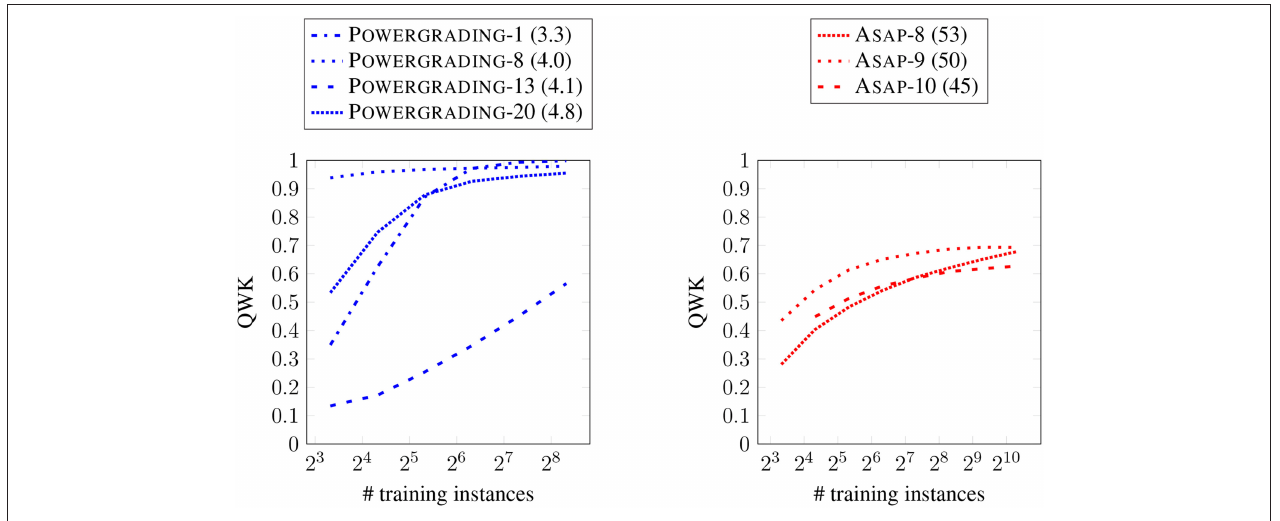
FIGURE 7 | Instance-based learning curves for POWERGRADING and ASAP prompts with comparable